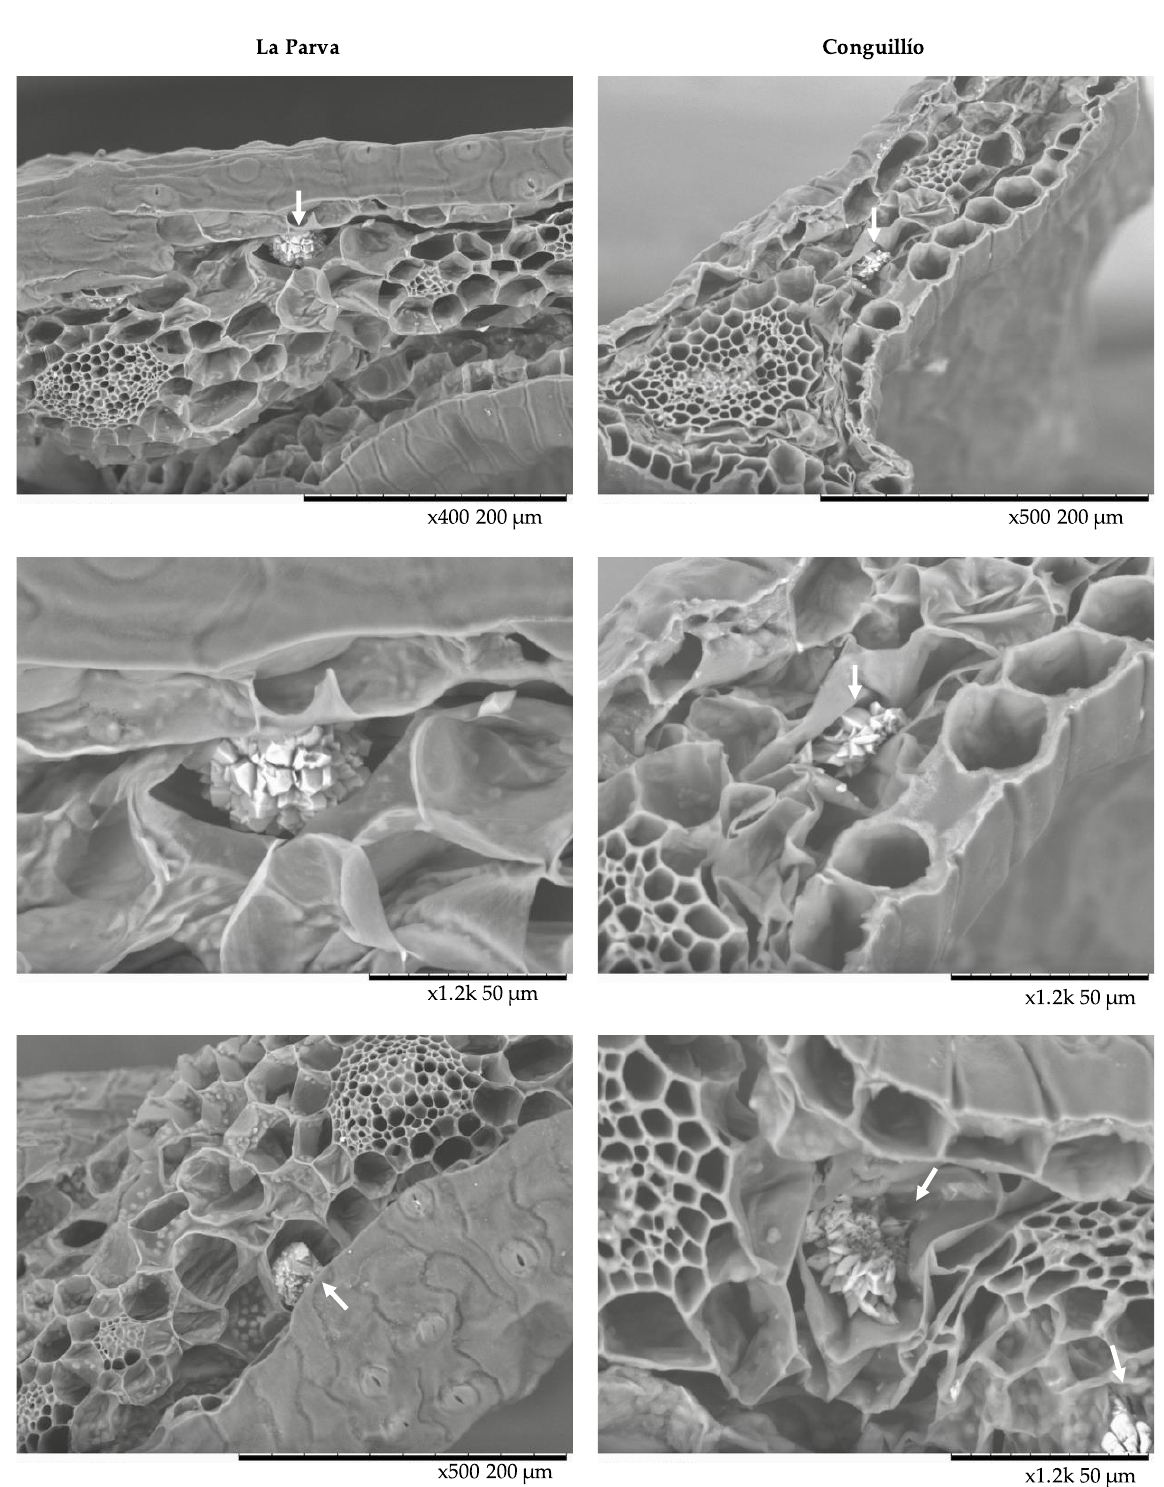
Figure 4. Scanning electron micrographs of calcium oxalate crystals in the leaf of Colobanthus quitensis from La Parva and Conguillío populations. Sizeable prickly crystals (white arrow) are located within mesophyll, near the vascular bundle.